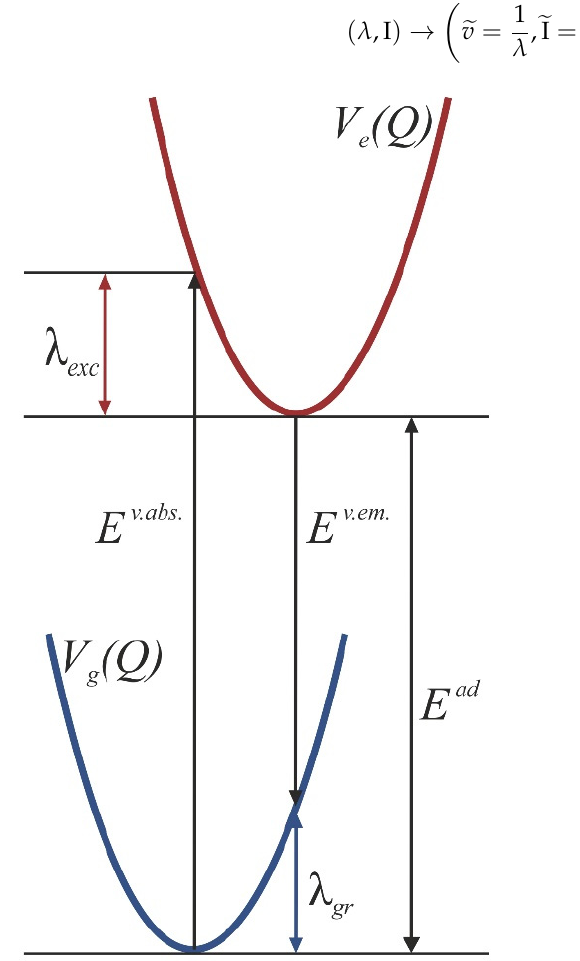
Figure 1. Scheme of the potential energe surfaces for the ground and for the excited state illustrating the concept of reorganization rnergies and the notation used in the text.